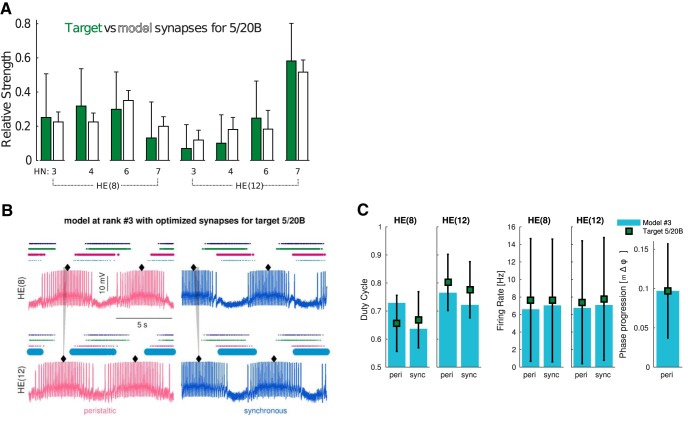
Adjusted synapses for target 5/20B for the model instance that has the same intrinsic maximal conductance magnitudes as in Figure 4. A, Relative synapse strengths (mean ± SD) recorded from preparation 5/20B (green bars) compared to 3717 models (mean ± SD, white bars) found after performing 10,000 MOEA model evaluations. Traces (B) and relevant metrics (C) of the third highest ranking model.